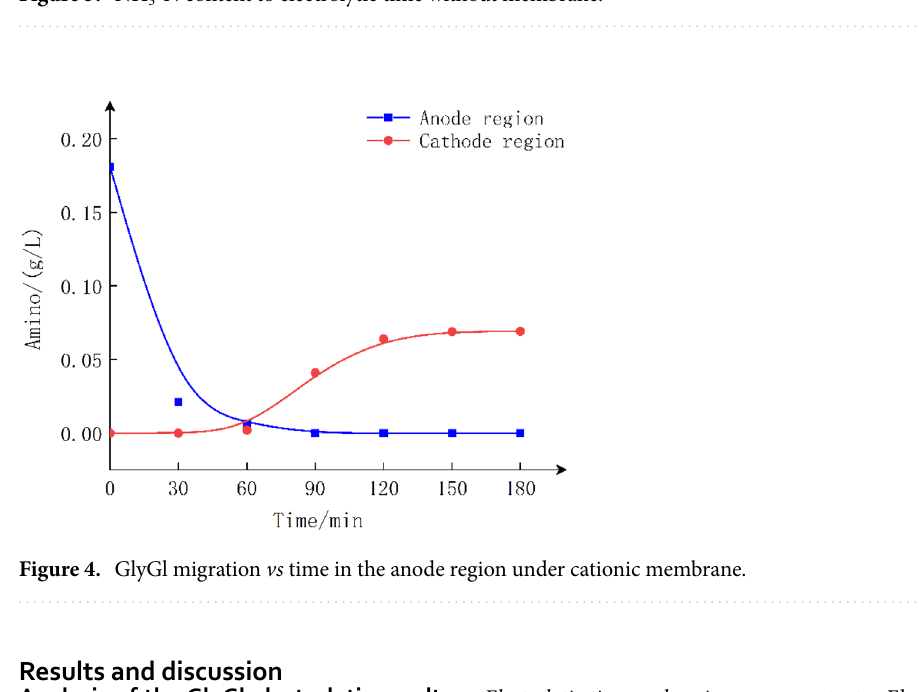
Figure 3. NH 3 -N content to electrolytic time without membrane.